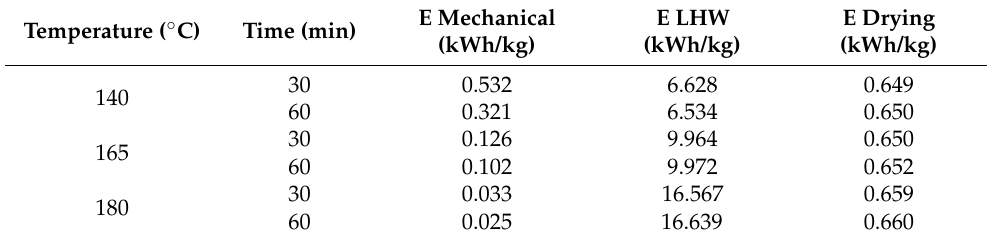
Table 1. The energy consumption of corncob pretreated by combined pretreatment at different conditions. Temperature ( ◦ C)